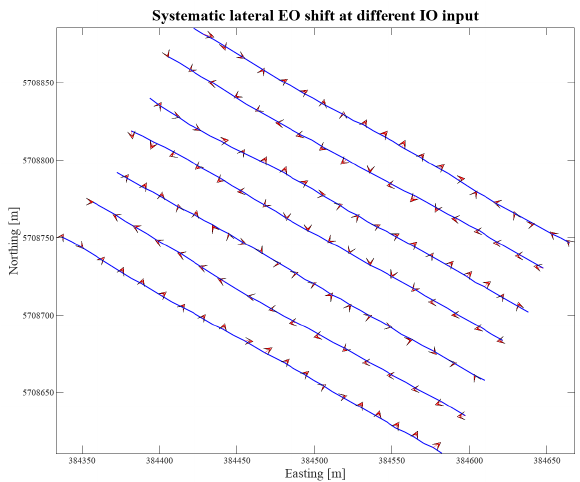
Figure 9. Absolute errors at check points with max error 2 . 5cm (red horizontal, pink vertical, blue flight